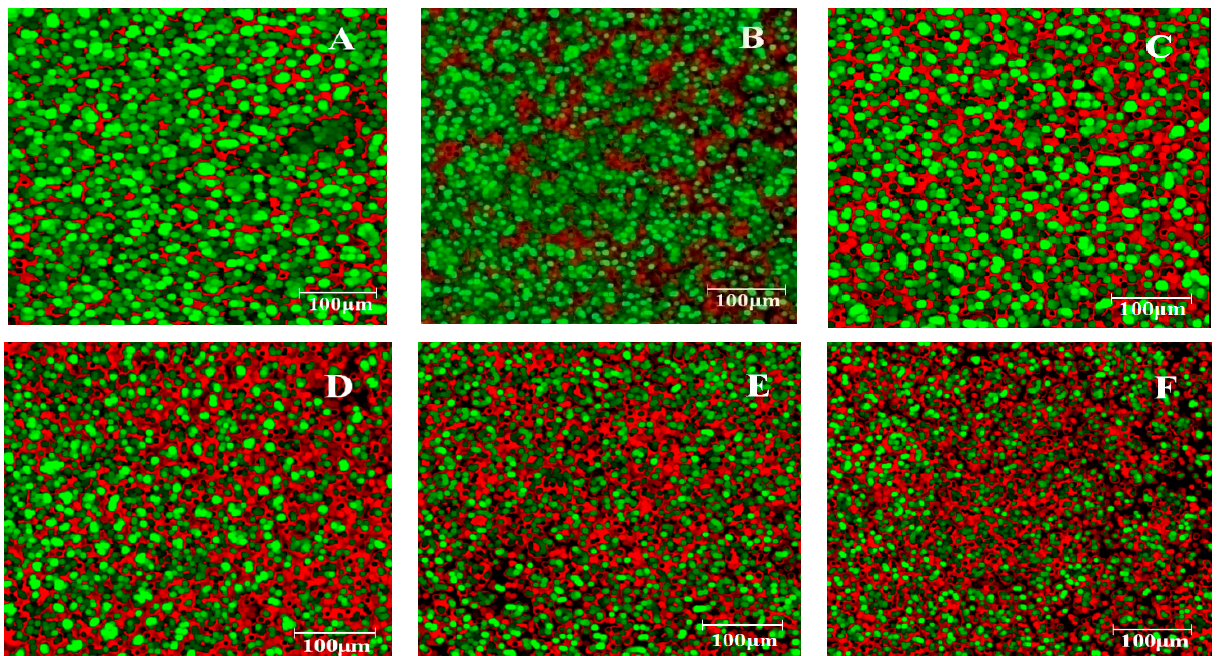
Figure 3. Microstructure taken by EFLM of the wheat dough with germinated bean flour (GBF) at different levels: 0% ( A ), 5% ( B ), 10% ( C ), 15% ( D ), 20% ( E ) and 25% ( F ). Red, protein; Green, starch granules.